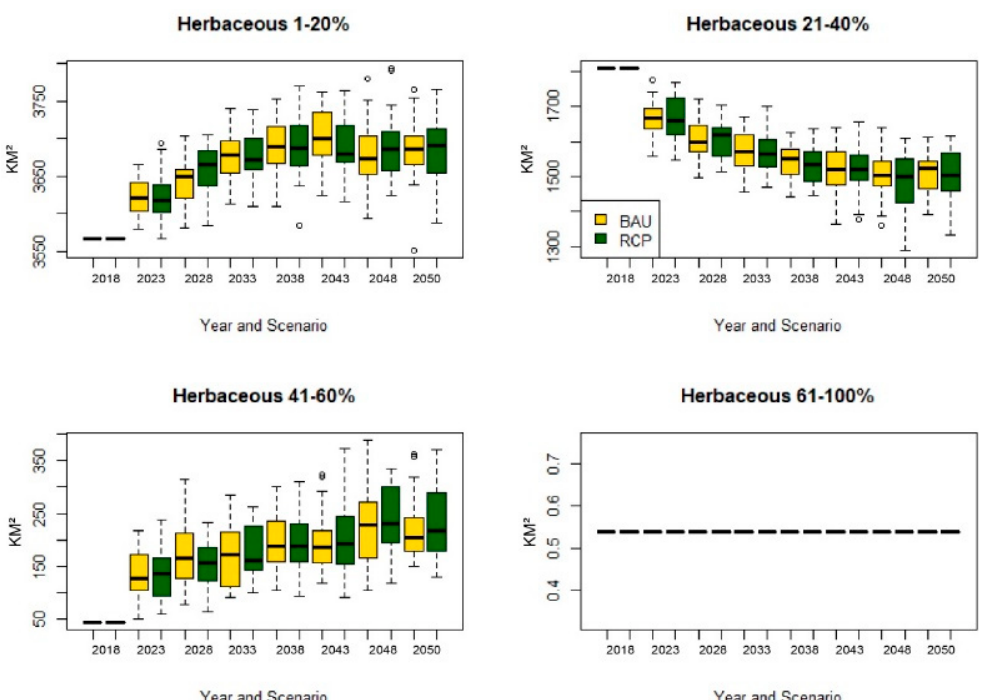
Figure 4. BAU and RCP 8.5 scenario results for herbaceous cover (km 2 ), summarized across the entire study area. Variance and means were calculated from across the 30 model runs. Data from 2018 have no error bars as they were observed directly using BIT data. No pixels have more than 60 percent herbaceous cover. The y -axis varies between plots.